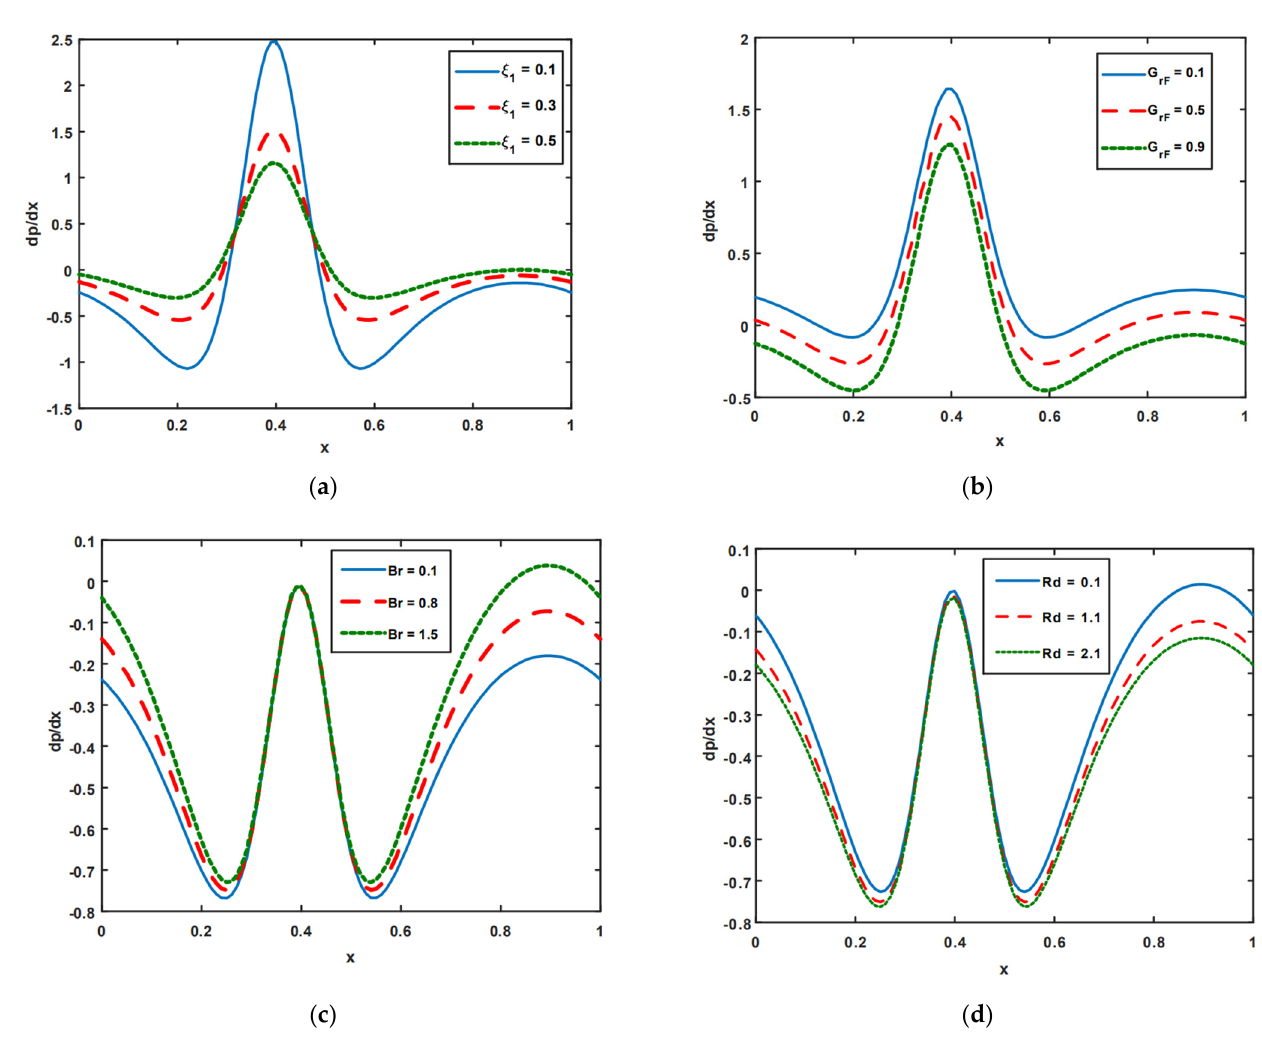
Figure 3. (a–d) Pressure gradient impact on 𝜉 (cid:2869) , 𝐺 (cid:3045)(cid:3007) , 𝐵𝑟 , and 𝑅𝑑 . Figure 3. ( a – d ) Pressure gradient impact on ξ 1 , G rF , Br , and Rd